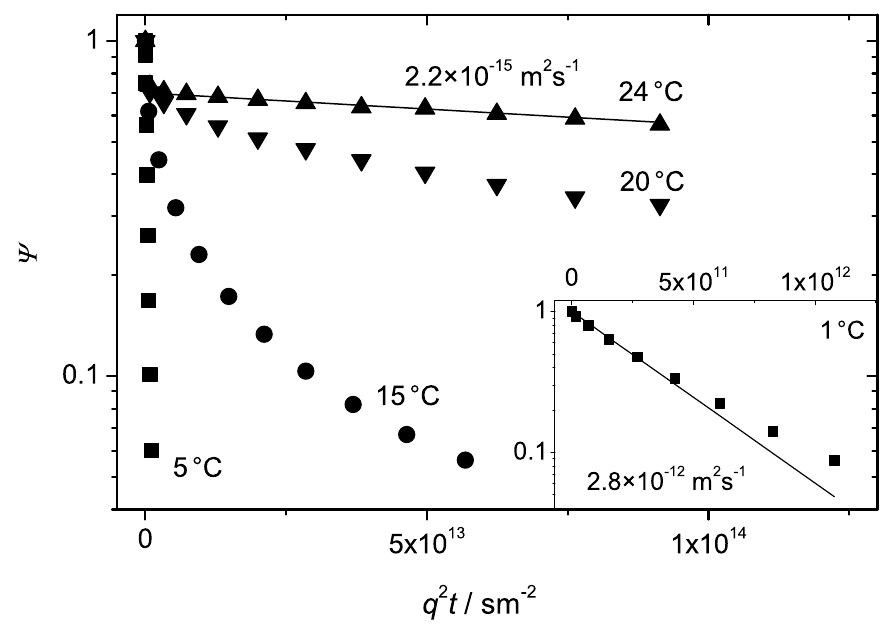
Figure 6. The normalized spin echo diffusion attenuations of the triblock copolymer P123 in water at c = 0 . 29 for four different temperatures. The inset shows the attenuation curve at 1 ◦